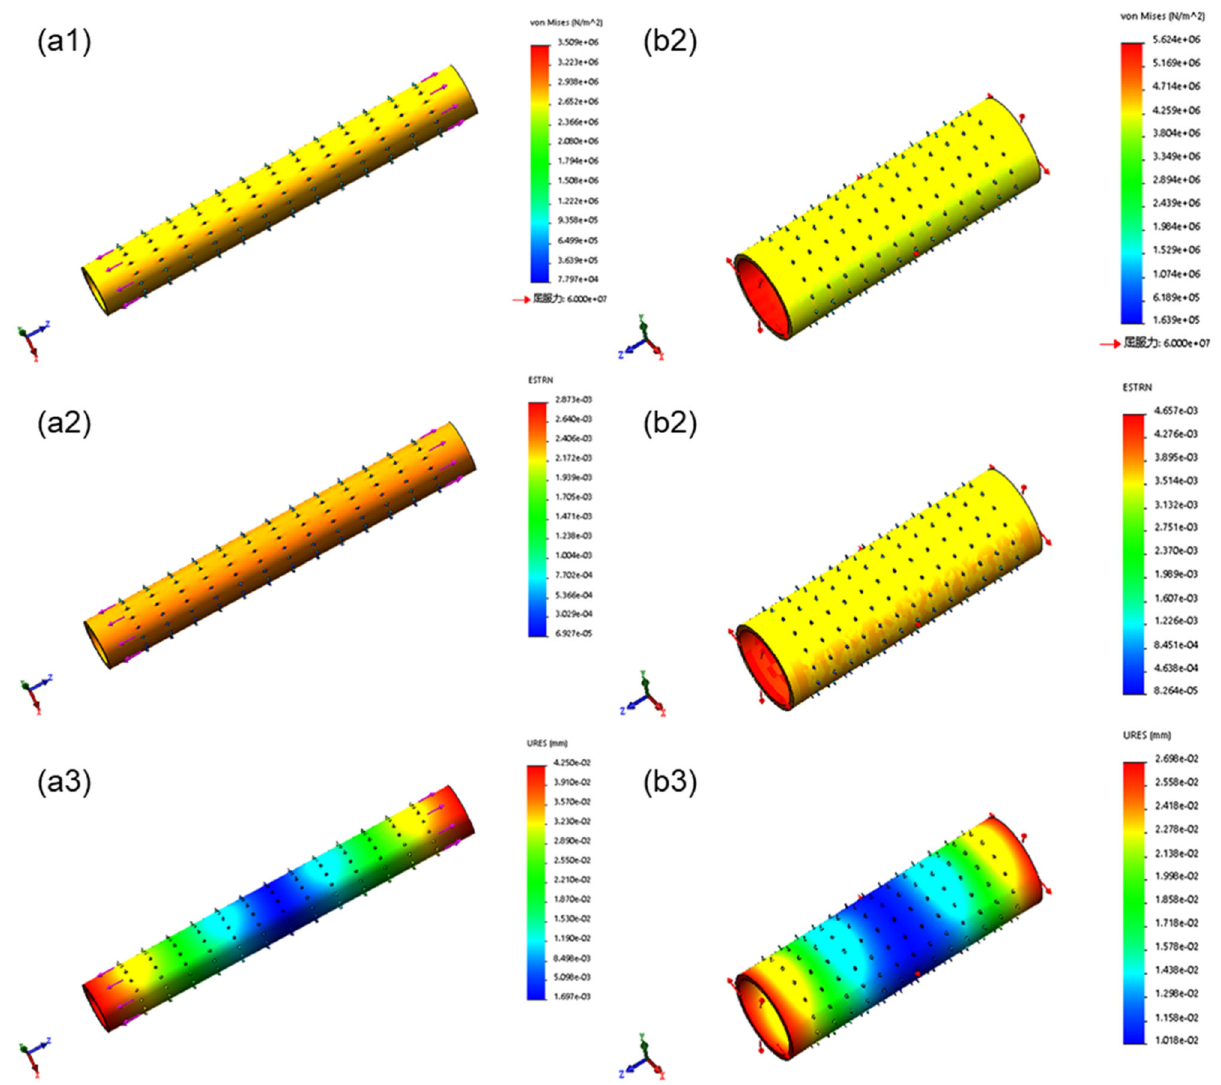
Fig. 6 Mechanical simulation of bioarti fi cial blood vessel with thorn-like protrusions: a1 Axial stress. a2 Axial strain. a3 Axial displacement. b1 Radial stress. b2 Radial strain. b3 Radial displacement